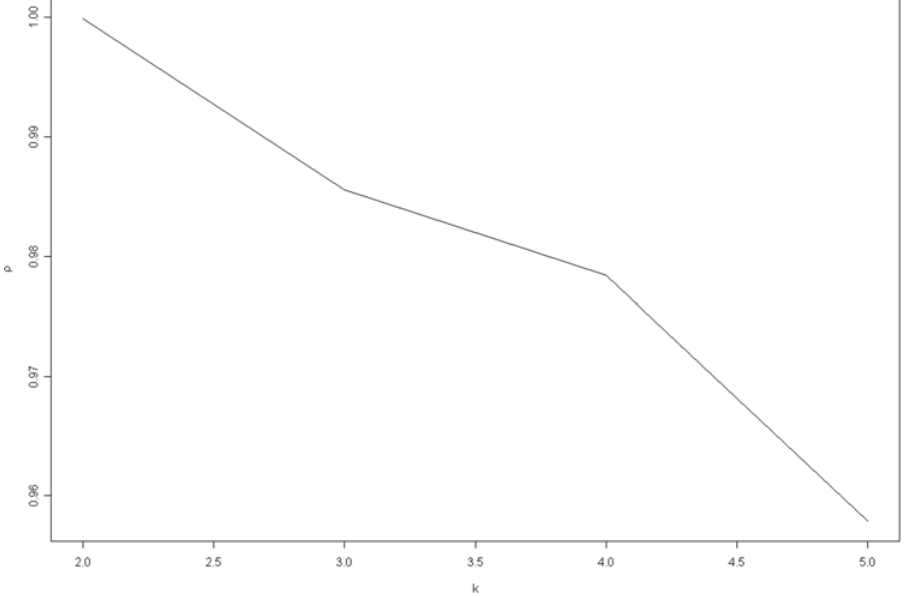
Figure 3. Cophenetic correlation coefficient.